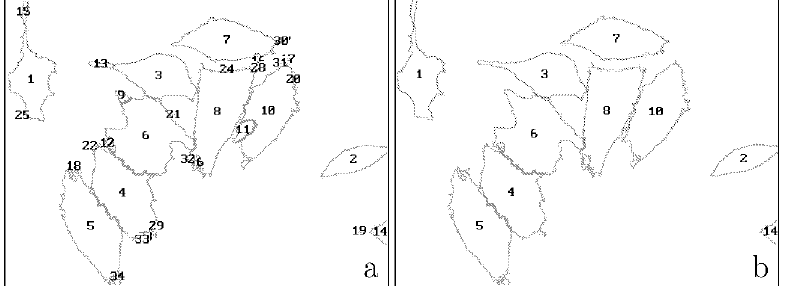
Fig. 6. Result of the initial segmentation process is shown in (a). Some objects are over-segmented, i.e., split in to several smaller parts, and a number of small noise objects are detected. The result after the merging step is shown in